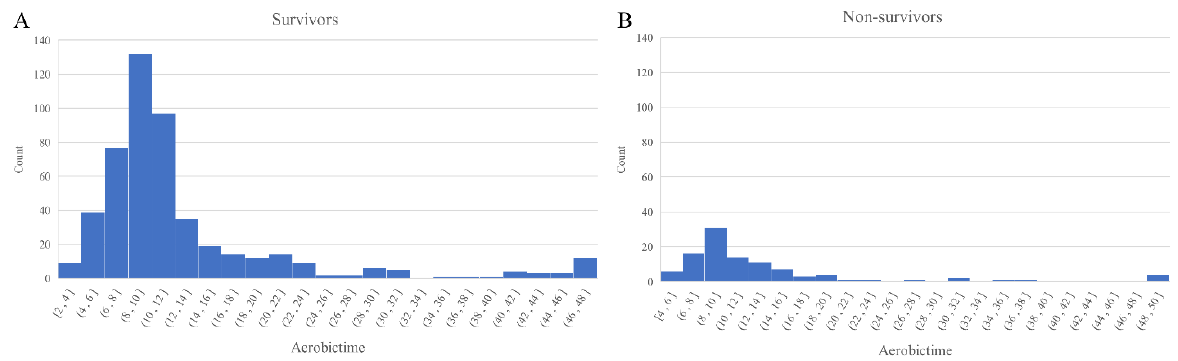
Figure 2. Distribution of the TTP values according to the 28-day mortality (( A ) survivors and ( B ) non-survivors). Abbreviations: TTP = Time-to-positivity.